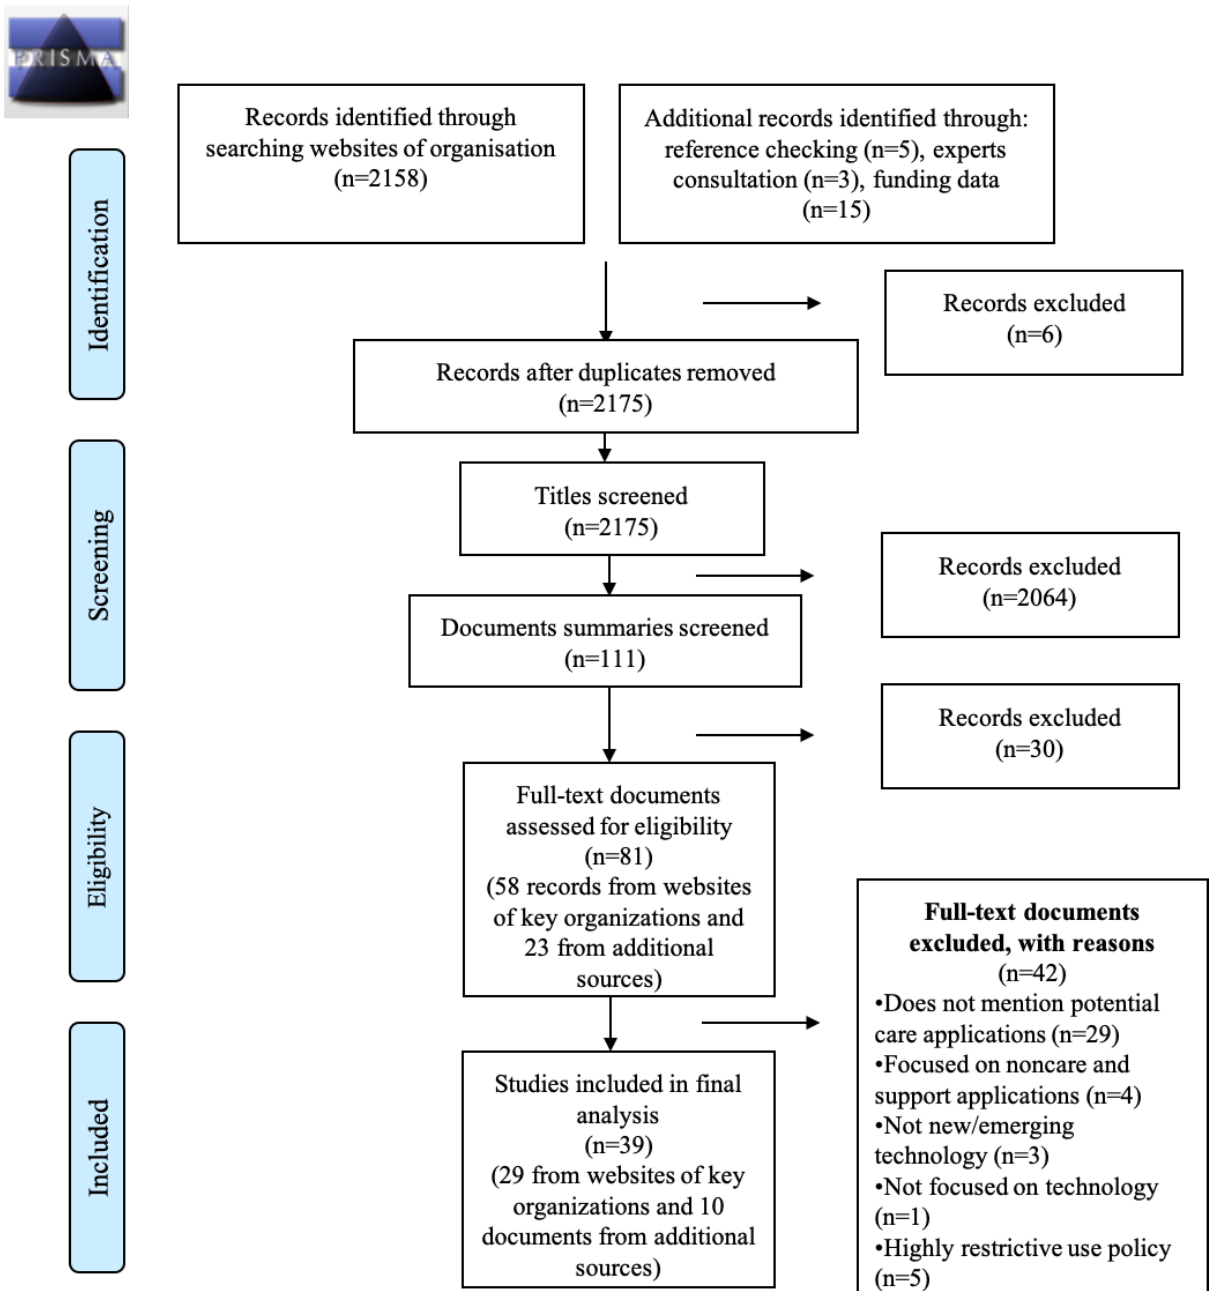
Figure 1. A summary of the screening and selection process using a PRISMA (Preferred Reporting Items for Systematic Reviews and Meta-Analyses)